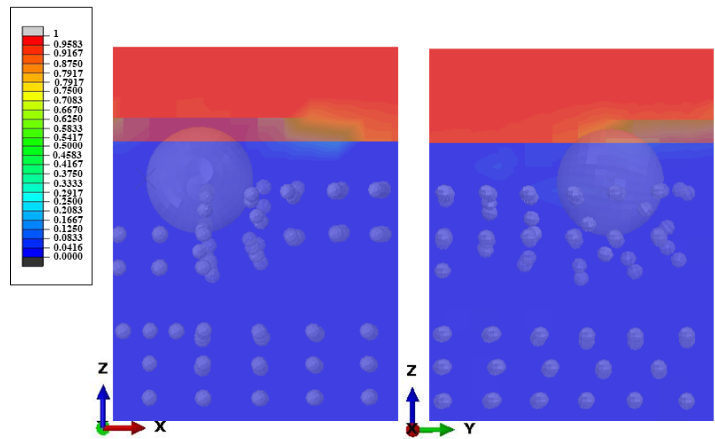
Figure 7. The sectional view of particle clustering under 40 Pa·s viscosity.